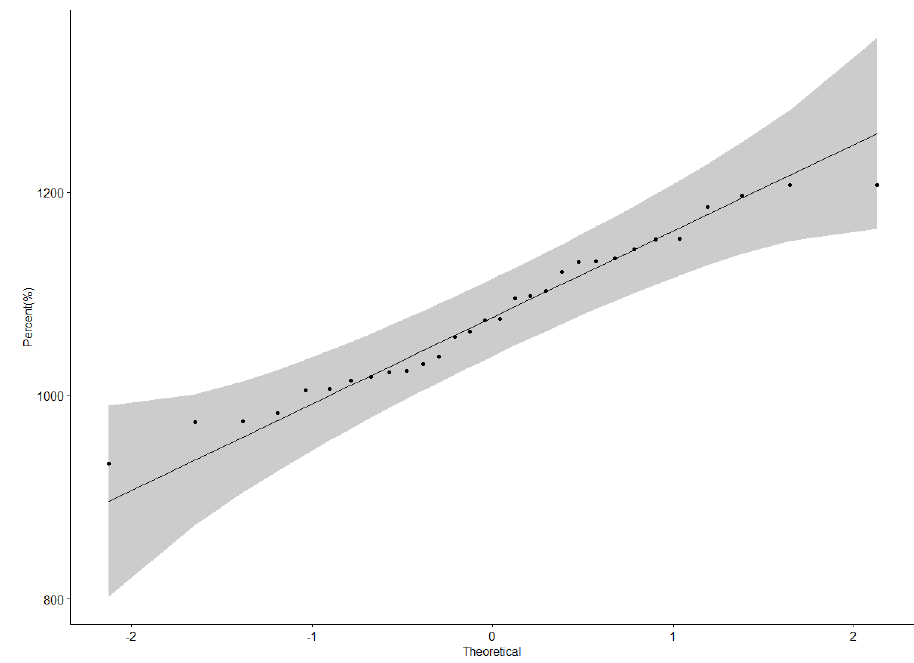
Figure 4. A GGE biplot showing the discriminating power and representativeness of test environ- ments involving 30 soybean genotypes evaluated in eight locations and six seasons .